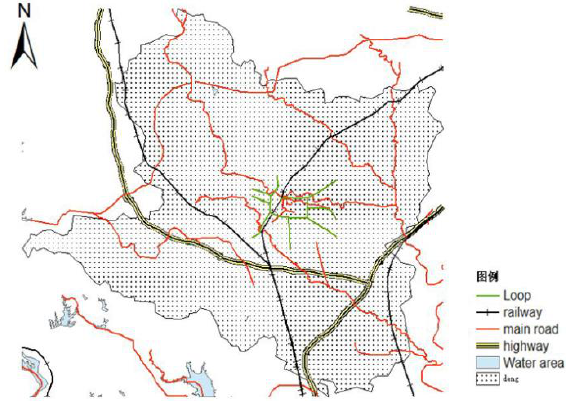
Figure 5. Dengzhou Road Network.